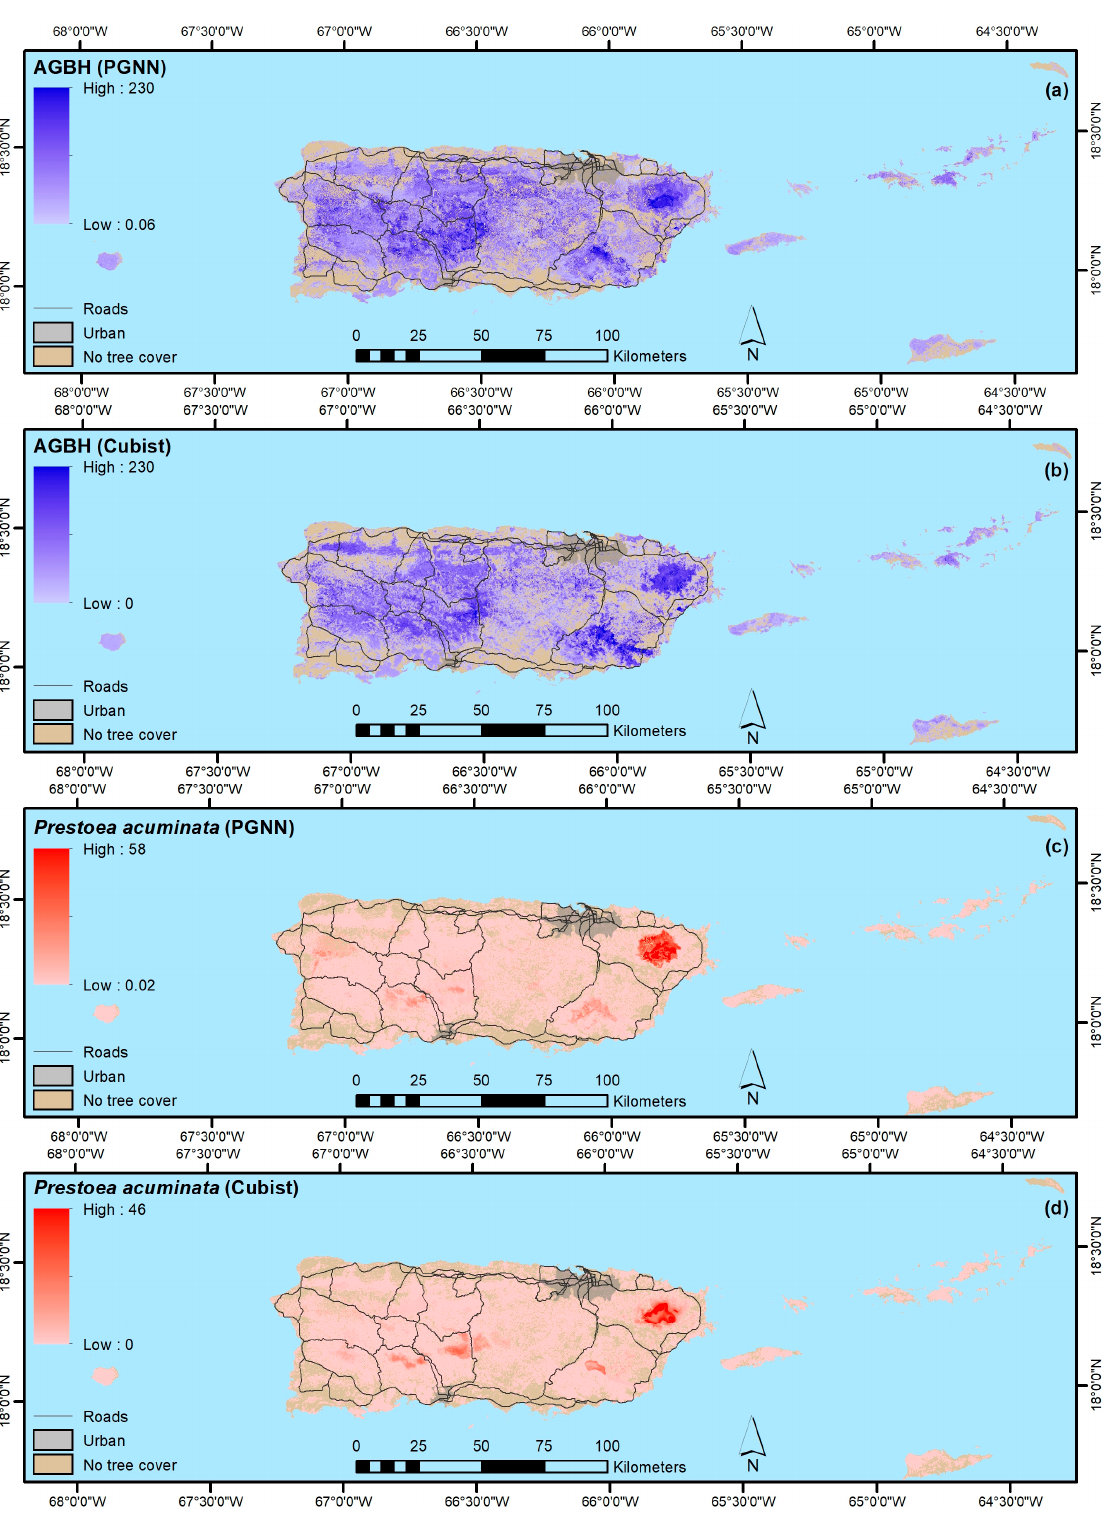
Figure 4. AboveGround Biomass per Hectare (AGBH) (live dry weight in Mg/ha) as mapped with ( a ) PGNN and ( b ) Cubist regression tree modeling, and basal area of Prestoea acuminata var. montana as mapped with ( c ) PGNN and ( d ) Cubist.